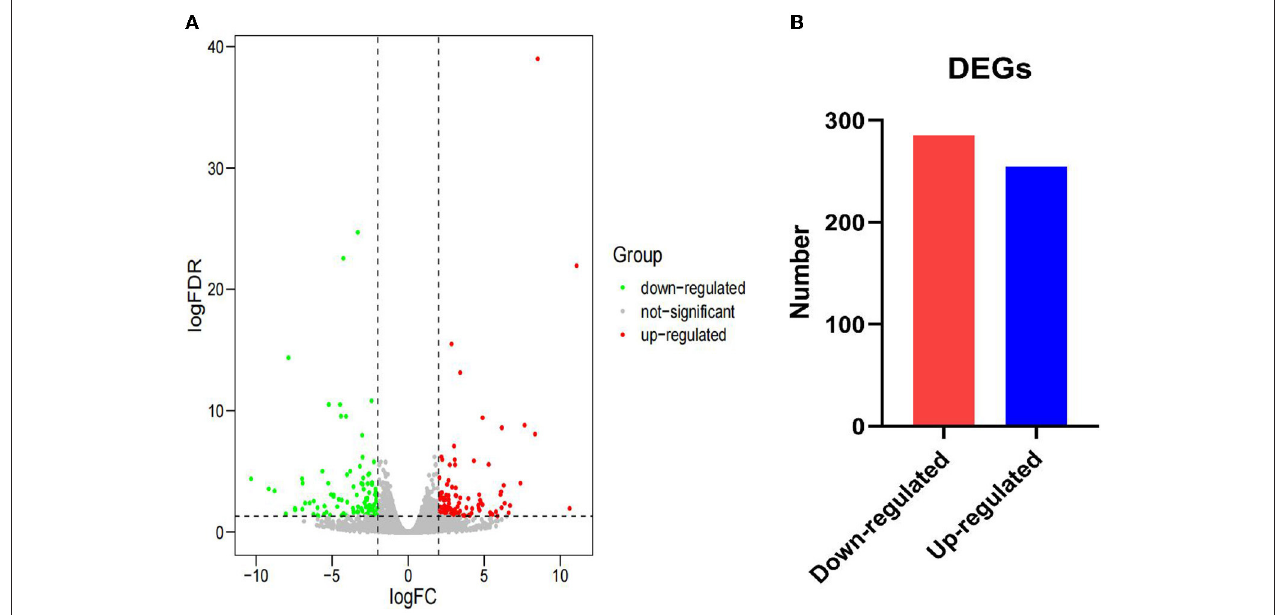
FIGURE 2 | Gene expression between the AR and ER groups. (A) The expression of differentially expressed genes (DEGs) between the two groups. The red dots indicate upregulated DEGs and the green dots indicate downregulated DEGs. The gray dots reveal that there is no difference in the expression of genes between the two groups. (B) Number of significantly